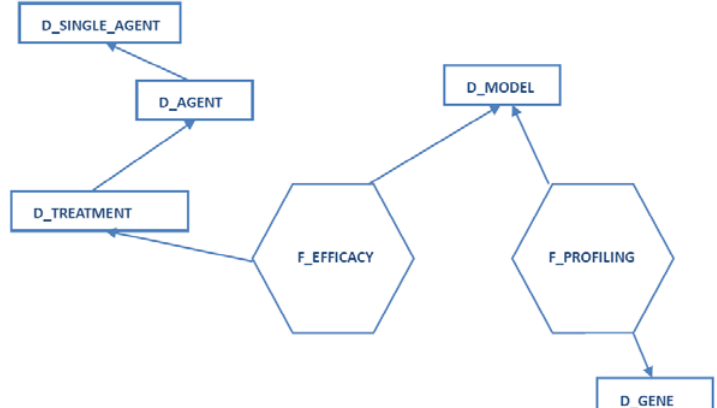
Figure 7: Mondrian used